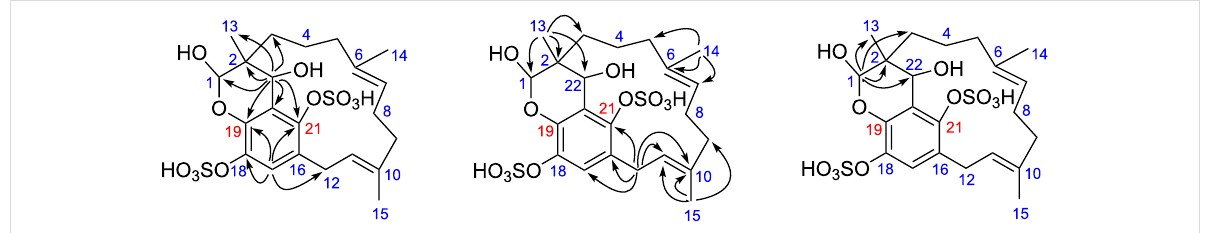
Figure 6: Selected 1 H, 13 C-HMBC correlations (H → C) observed for siphonodictyal E4 ( 4a ).